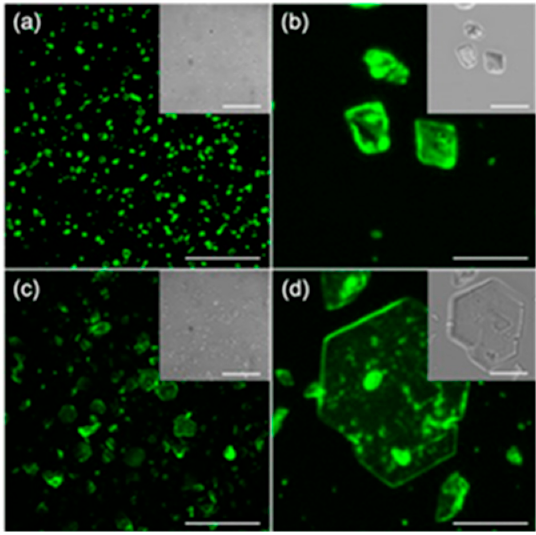
Figure 5. Confocal microscopy images of calcite crystals with adsorbed calcein. ( a , b ) {10.4} calcite, ( c , d ) {00.1} calcite. The insets show the corresponding transmission optical microscopy images. The scale bars are 50 µm ( a , c ) and 10 µm ( b , d ).